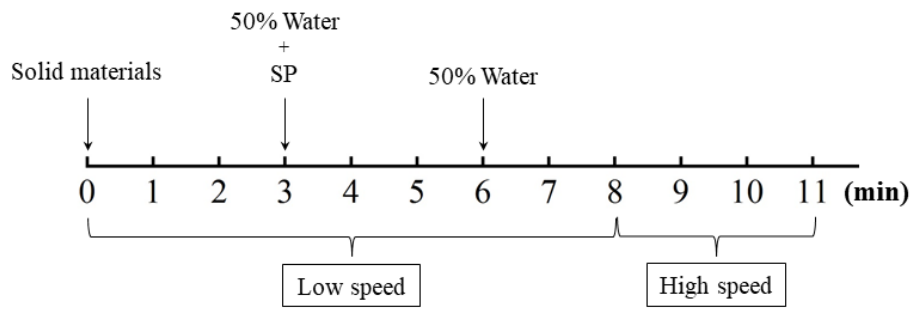
Figure 5. Mixing procedure of UHPC.